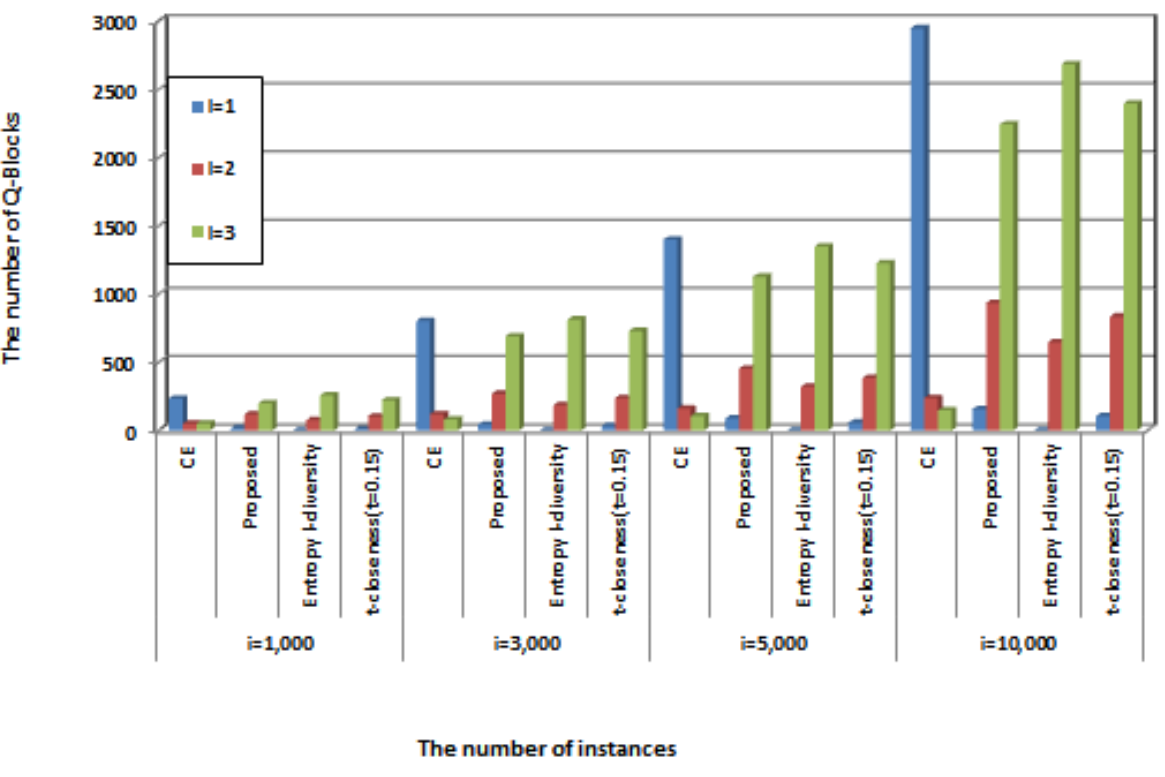
Figure 5. Comparison of the number of Q-blocks, which are l=1 (homogeneity attack), l=2 (background knowledge attack), and l=3 (safe), to measure the diversity (the size of Q-block is set to 3).